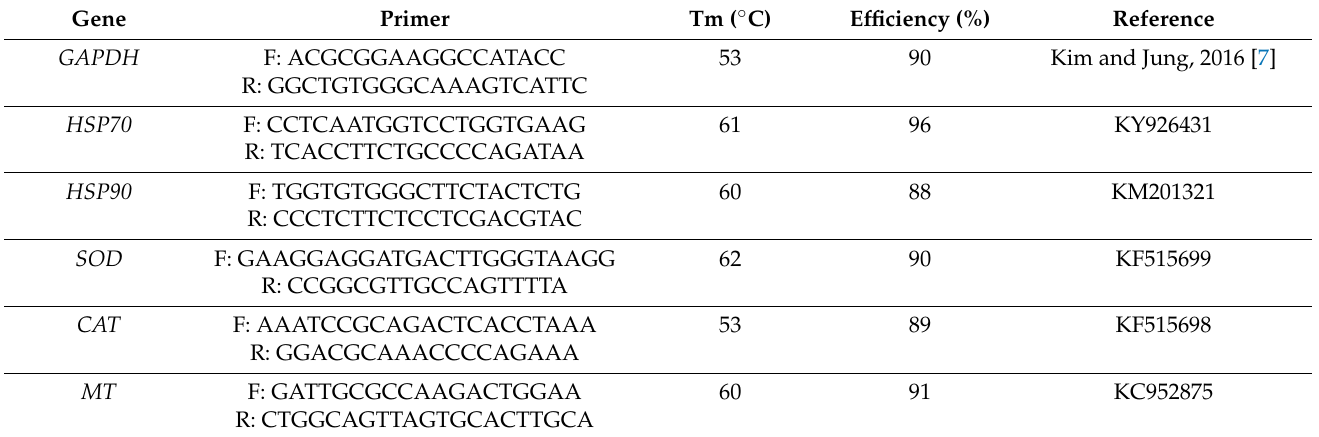
Table 1. List of specific primers used for quantitative real-time